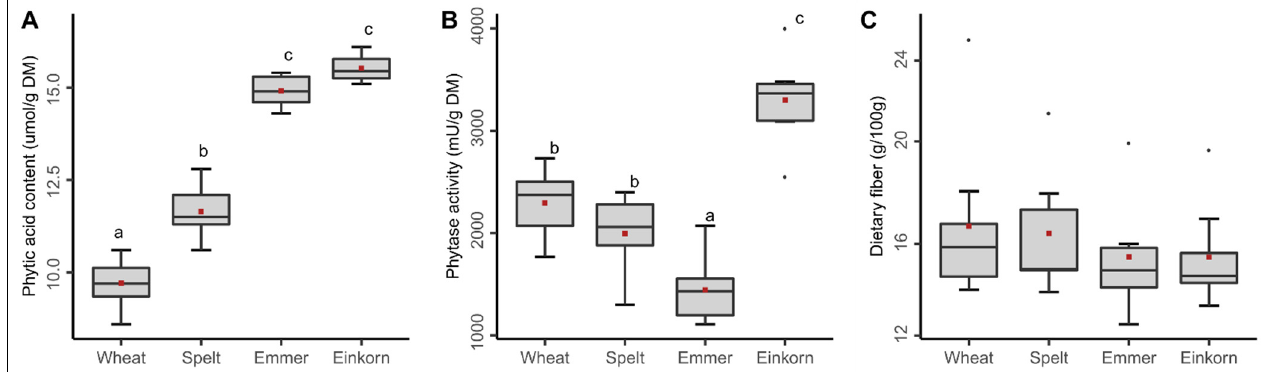
Figure 3. Phytic acid content ( A ), phytase activity ( B ) and total dietary fiber content ( C ). Boxes with different letters indicate significant differences between the wheat species (ANOVA with Tukey’s test, p < 0.05). Each box summarizes the content of 24 samples (eight varieties grown at three locations in trial series 2). Mean values for each species are highlighted in red color.